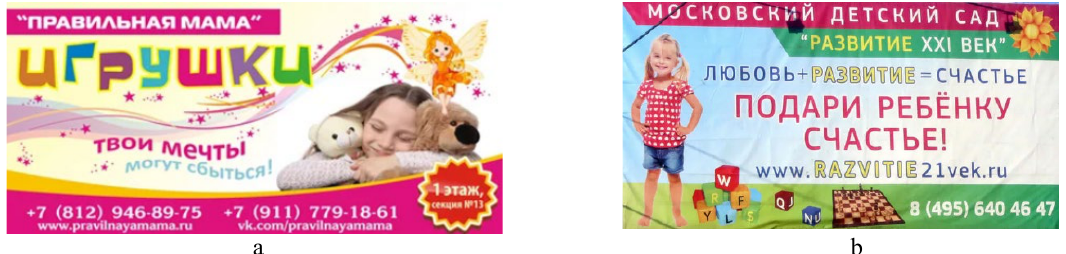
Figure 5 – Examples of advertising appealing to children and their parents